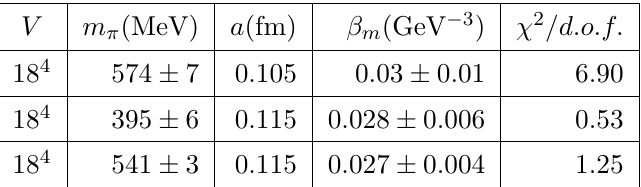
Table 2 . The magnetic dipole polarizability (cid:12) m of the charged (cid:26) meson with spin projection s z = 0 obtained from the (cid:12)ts (5.2) of the lattice data sets. The pion masses are represented in the second column, the lattice spacings in the third column, the values of (cid:31) 2 =d:o:f are shown in the last one.